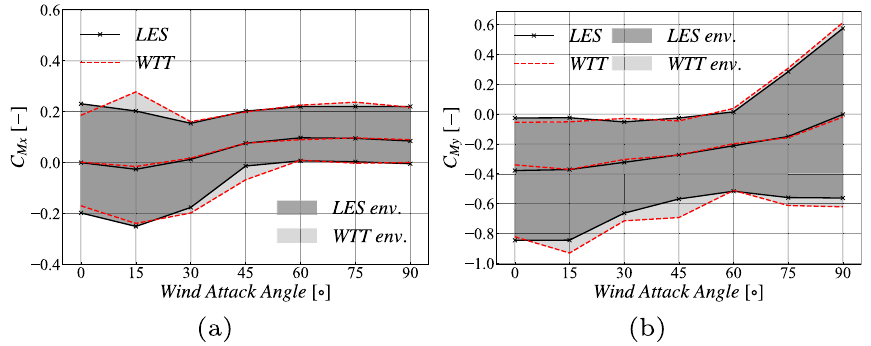
Fig. 9 The moments coefficients of all the simulated wind attack angles: ( a ) C Mx and ( b ) C